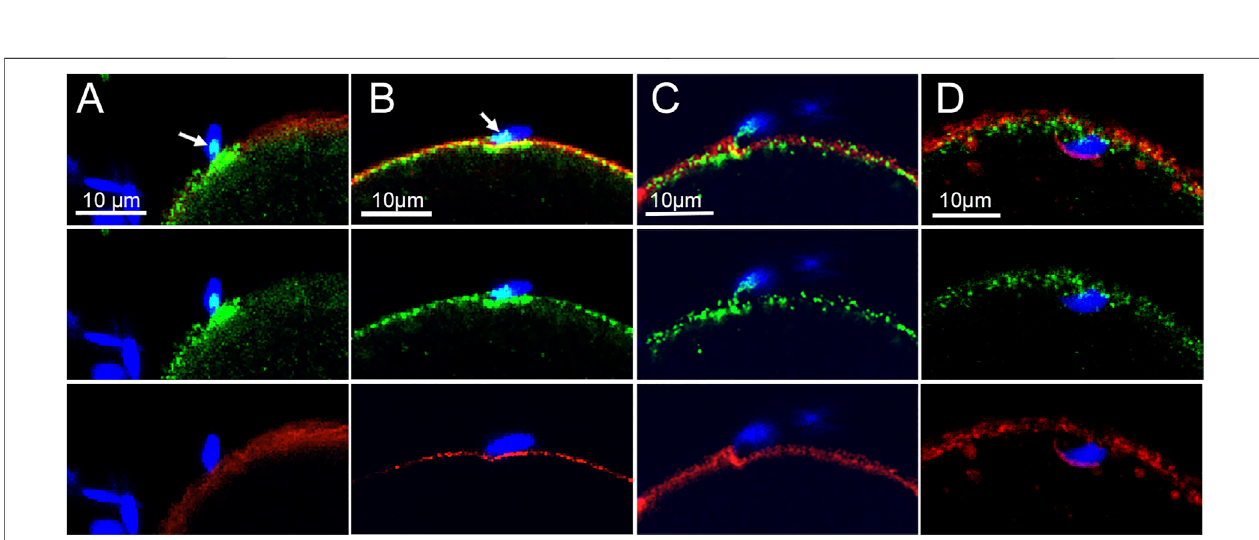
FIGURE2| LocalizationofRhoAatthespermbindingsite.Oocytes fi xedatdifferentstagesoffertilizationwerelabeledwithanti-RhoA(green)andAlexaFluor-568 phalloidin (red) as well as Hoechst 33342 (blue). (A) recently bound sperm with a Rho A patch on the sperm head (arow) and a plaque of oocyte-derived Rho A underneath. (B) oocyteRhoAplaqueunderlingtheactinlayeratthespermbindingsite(arrowindicatesapatchofspermRhoA). (C) invaginationofthecorticalactinlayer withassociatedRhoAfoci (D) incorporatedspermwithfewremainingRhoAfoci.Imageswereselectedfrom24oocytesrecoveredfrom3females.Magni fi cationis indicated by the